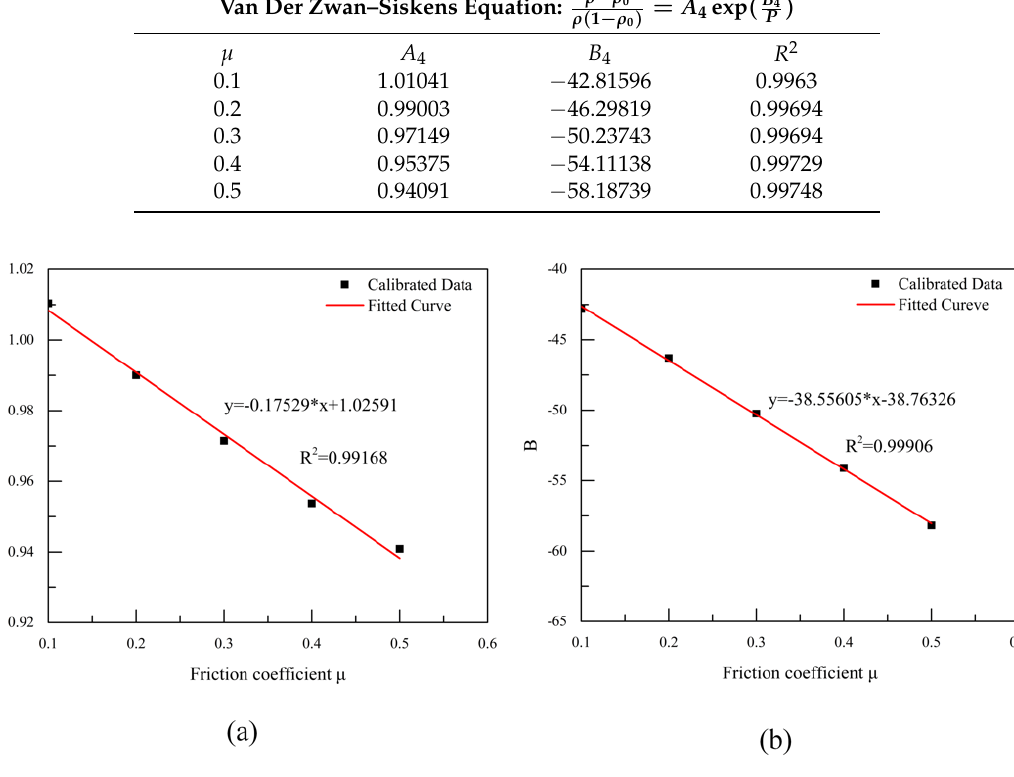
Figure 16. Fitting curves of parameters in Van Der Zwan–Siskens compaction equation: ( a ) parameter A and ( b ) parameter B.